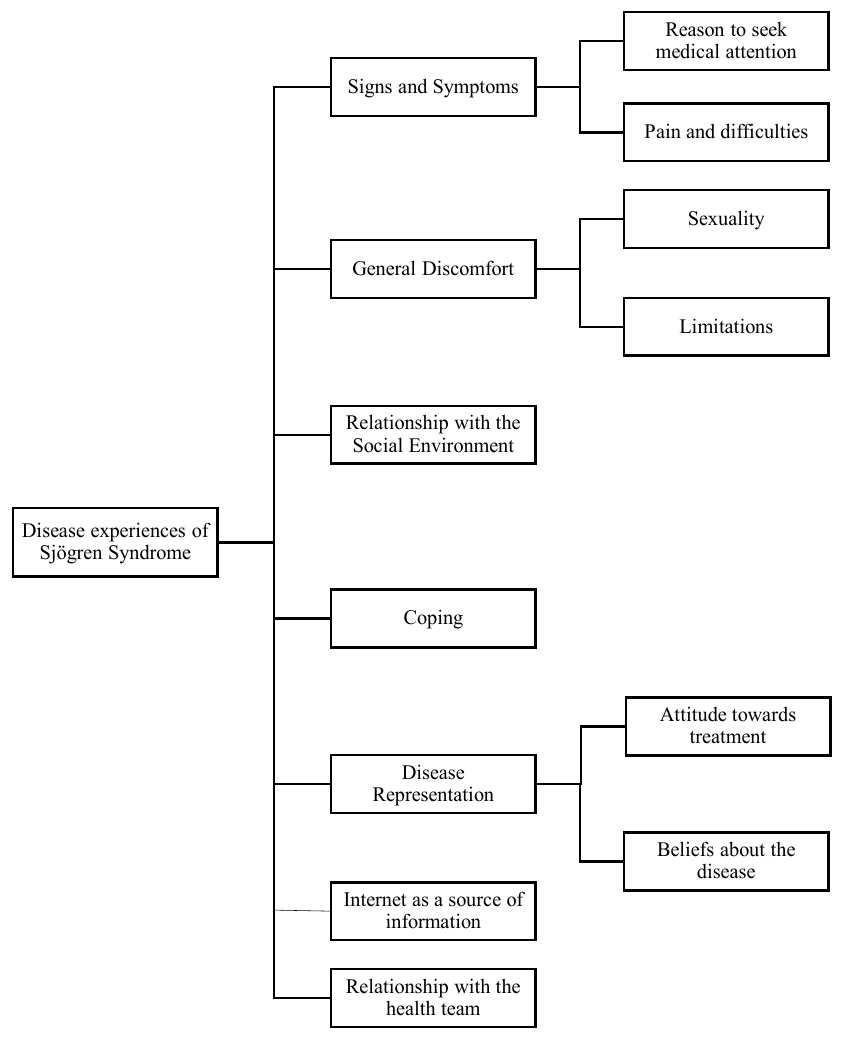
Figure 1. Schematic overview of the outcome of hierarchical cluster analysis grouping the 70 expe- riences of having SS.